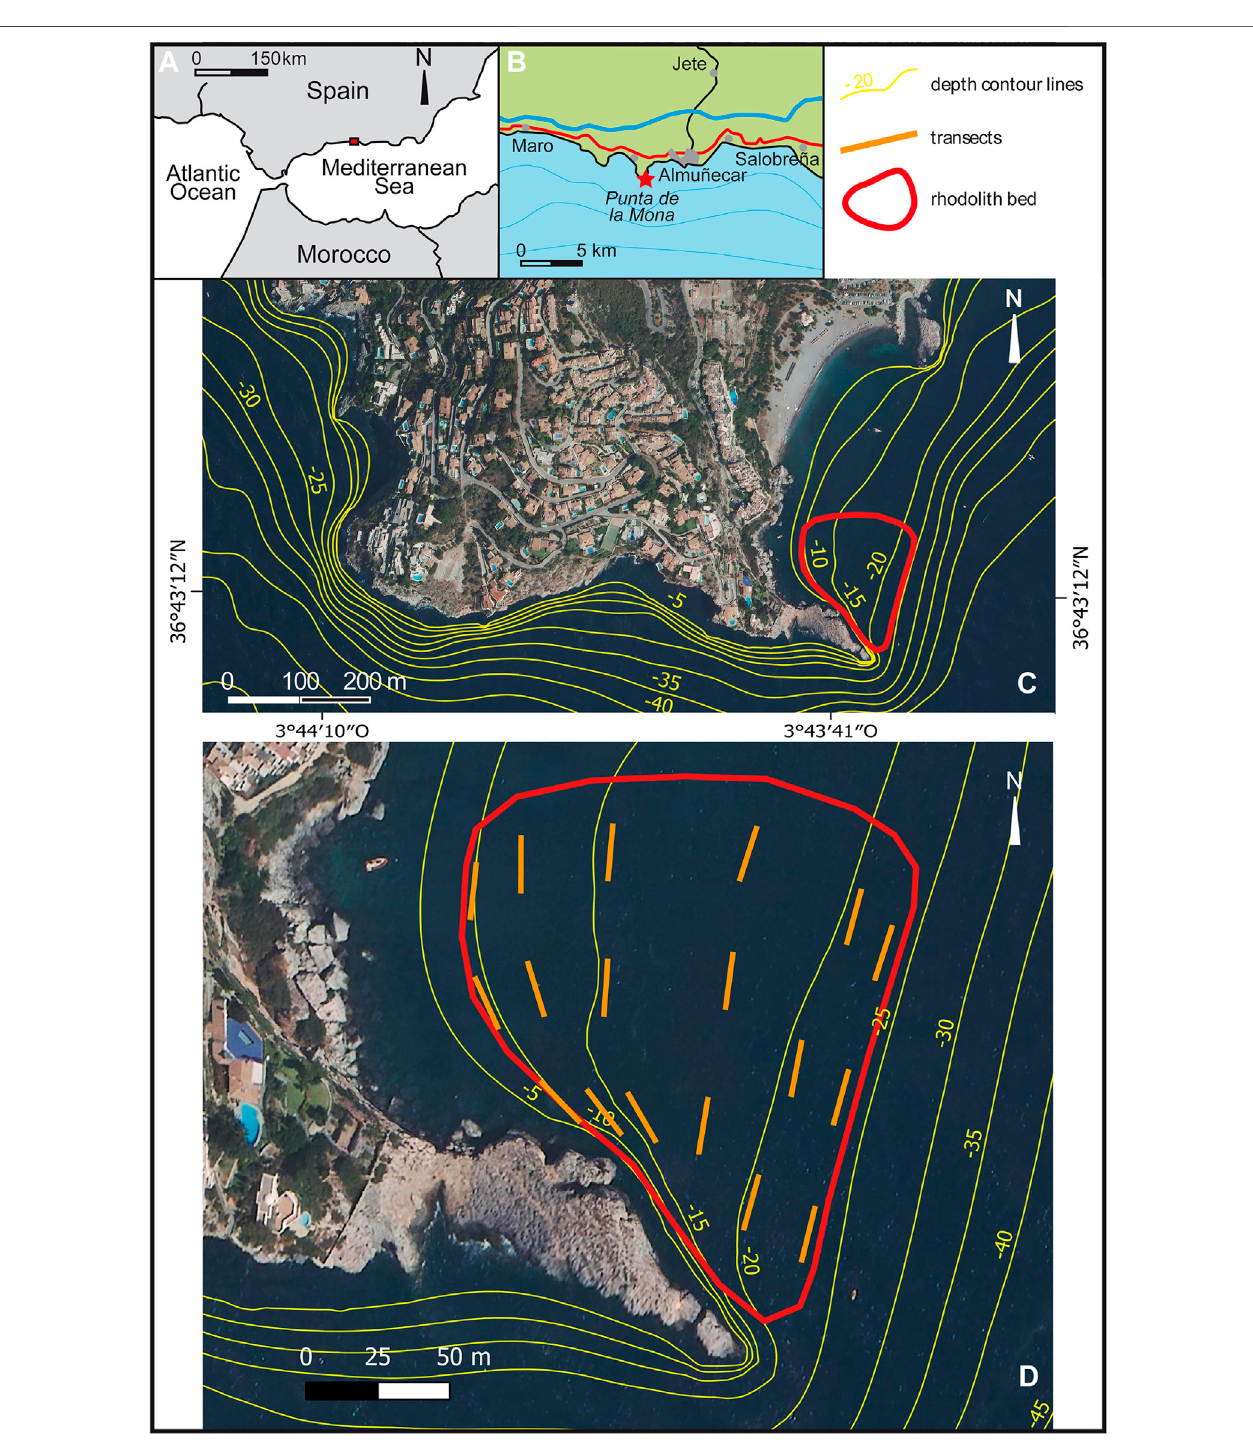
FIGURE 1 | Study area east of Punta de la Mona in southern Spain.